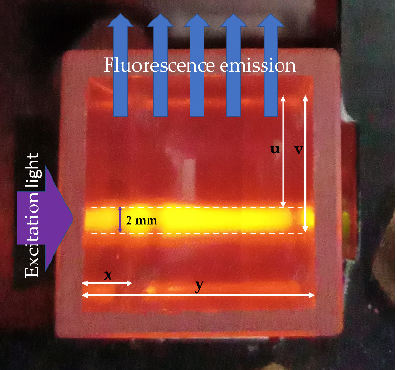
Scheme 1. Top view of the 1 cm quartz cell used in the experiments. The geometric parameters used in the calculation of the IFEs were determined using Rhodamine 101 in water (excitation at 577 nm) and are as follows (in cm): x = 0.1, y = 0.9, u = 0.55, and v = 0.75. Förster radii R 0 were calculated from the expression R 06 = 8.79 × 10 − 5 ( κ 2 n − 4 Φ D J ( λ )), in Å 6 , where κ 2 is the spatial orientation factor expressing the orientation of the interacting D-A transition dipoles, n is the refractive index of the medium, Φ D is the fluorescence quantum yield of D (in the absence of A), and J ( λ ) is the overlap integral of the fluorescence (cid:82) F D ( λ ) ε A ( λ ) λ 4 d λ , expressed in M − 1 cm − 1 nm 4 , where integral is in turn given by: J ( λ ) =